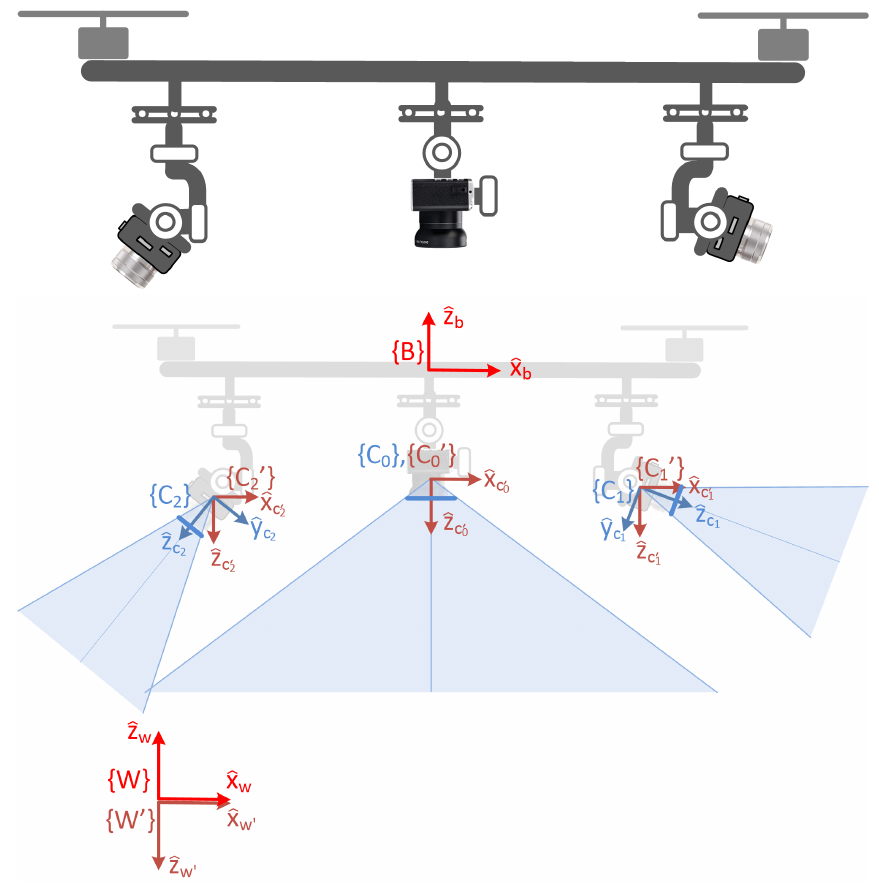
Figure 1. Illustration of the concept using a multirotor platform, a central wide-angle camera on a 2-DOF gimbal, and two tracking cameras with their respective 3-DOF